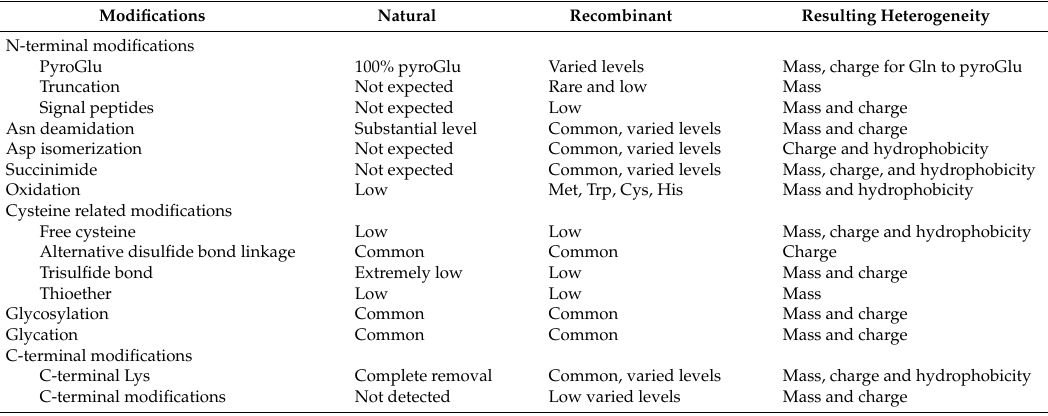
Table 1. Micro-heterogeneity natural IgGs and recombinant